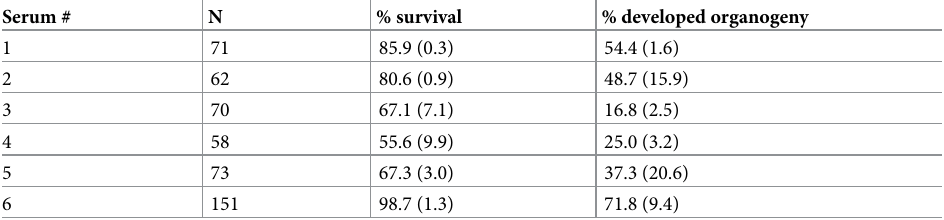
Table 2. Comparison of the promotion of development to the organogeny stage, by each of the sera added to HM. Serum # N % survival % developed organogeny 85.9